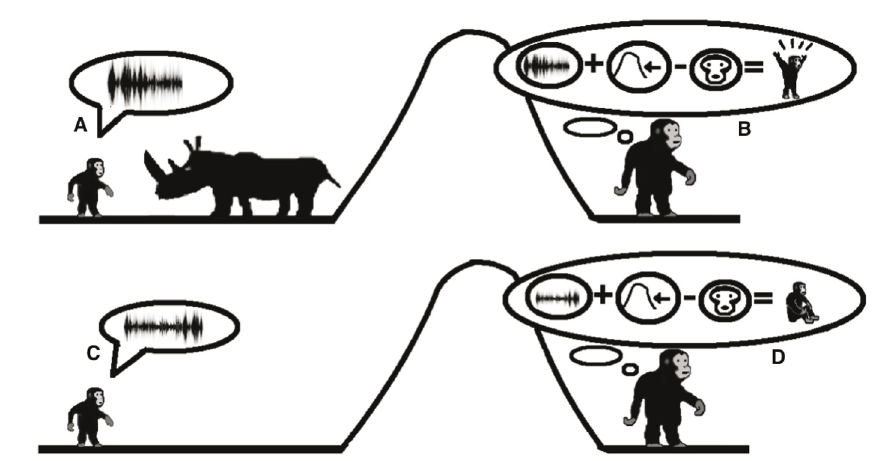
Figure 3. The use of prosody to signal levels of distress. In accordance with the model, early Hominans became capable of modifying their contact calls with intonations (prosody). This modification could have originated for the purpose of expressing different levels of distress. In this figure, we see a Homo habilis child using prosody to modify the contact call to express a high level of distress ( A ) or a low level of distress ( C ). The child’s mother then registers the call (by integrating his prosodic intonation and voice, location, and the absence of his face) to recognize whether her child requires immediate ( B ) or non-immediate ( D )